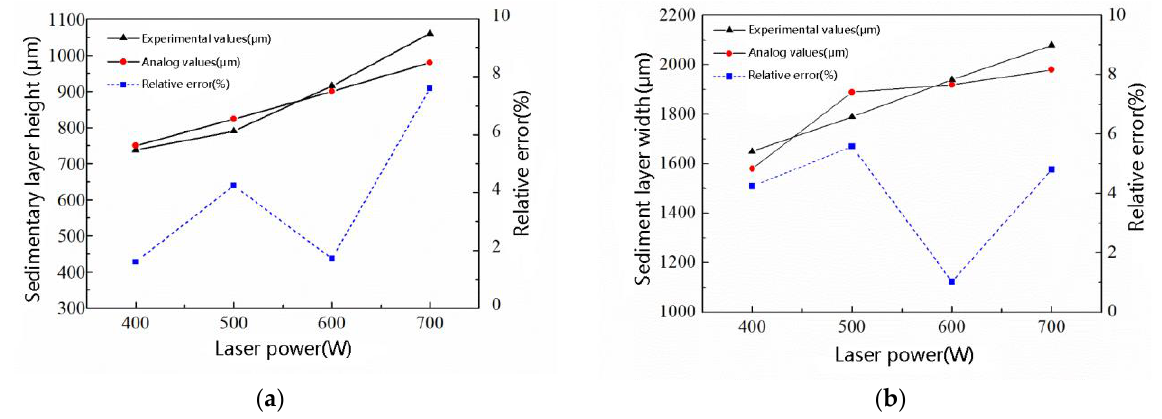
Figure 9. Deposition channel size under different laser power. ( a ) Sedimentary channel height varies with scanning speed; ( b ) Sedimentary channel width varies with scanning speed.